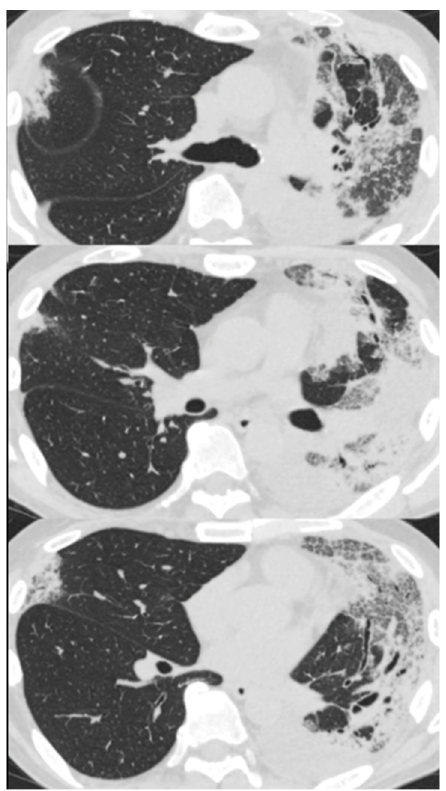
Figure 4. Chest computed tomography of a 59-year-old man with dyspnea scan showed consolidation in the entire left lung field and a leftward deviation of the mediastinum due to contractile changes. A slight consolidation was seen just below the peripheral pleura in the right upper and middle